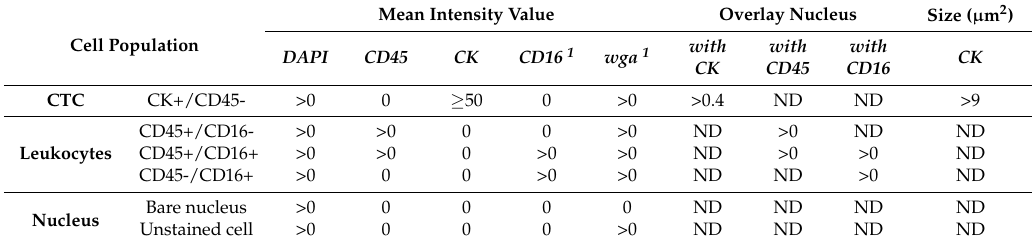
Table 2. The definition of cell populations used to classify cells in ACCEPT after deep learning segmentation in 300 non-small cell lung cancer (NSCLC) patient samples and 127 samples from healthy